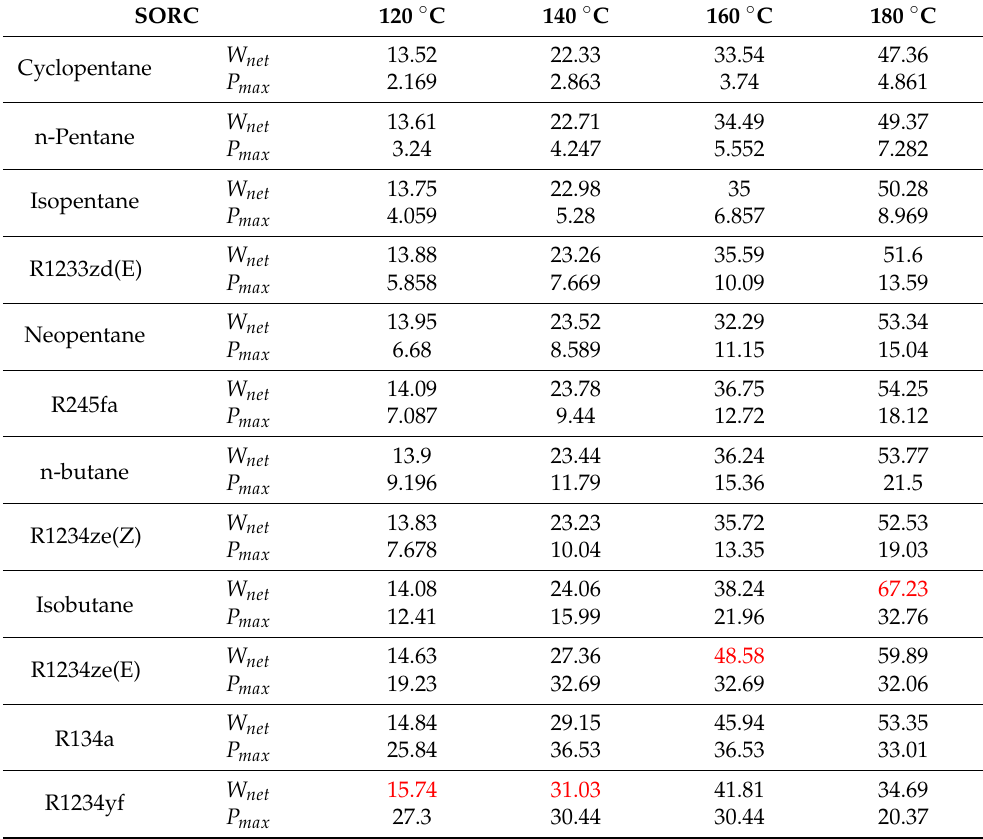
Table A5. The obtained results of the net power optimization for the SORC